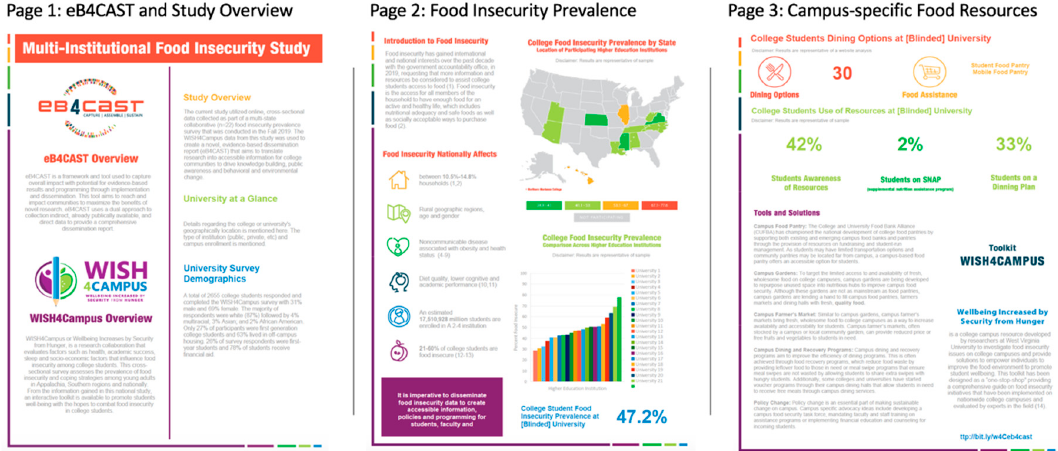
Figure 1. Sample evidence-Based forecast C-capture, A-assemble, S-sustain, T-timelessness (eB4CAST) food insecurity